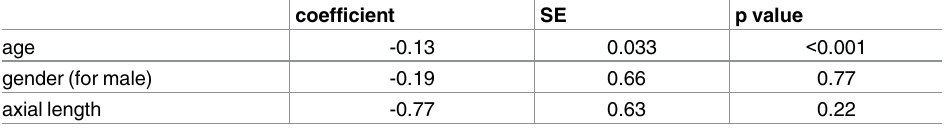
Table 4. The relationship between RPE+OS thickness and age, axial length and gender.